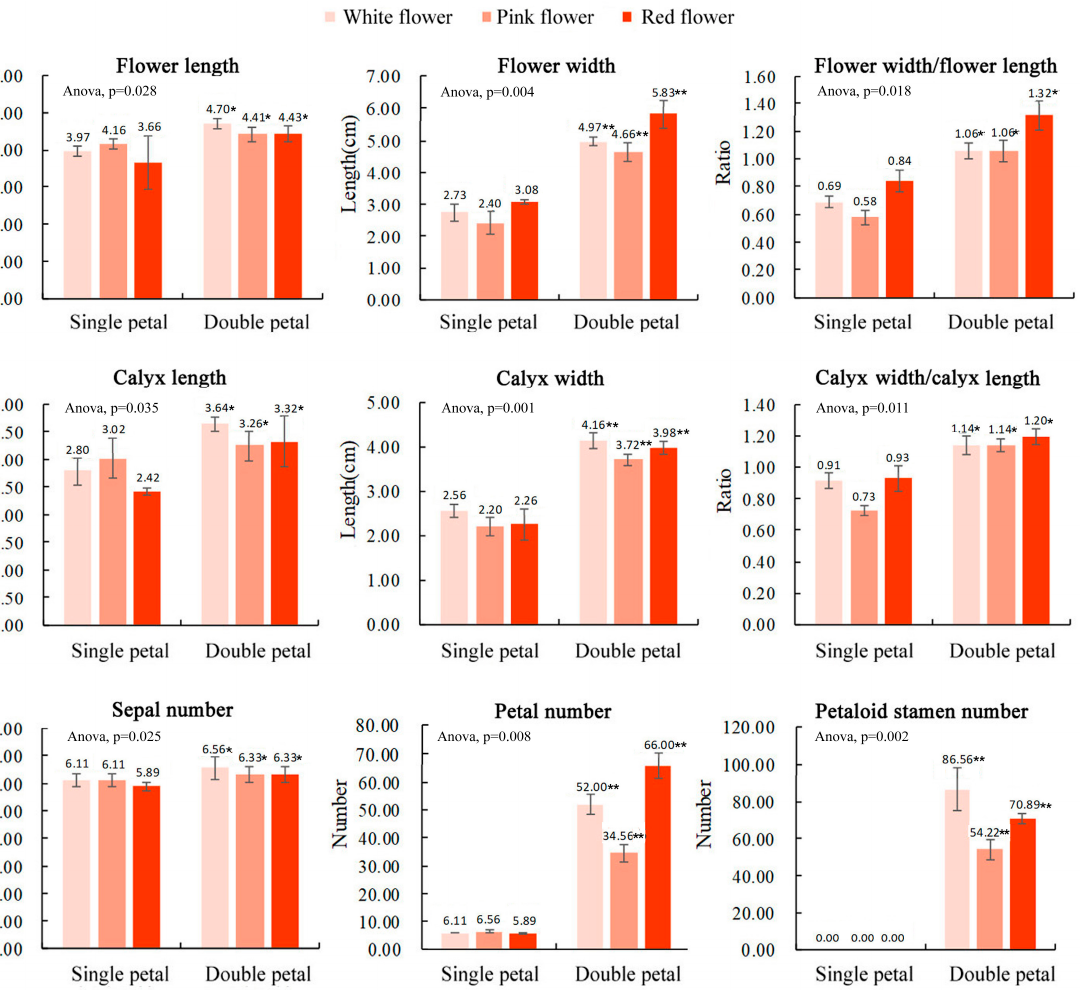
Table 2. Summary of the sequencing data of 6 ornamental pomegranate varieties.